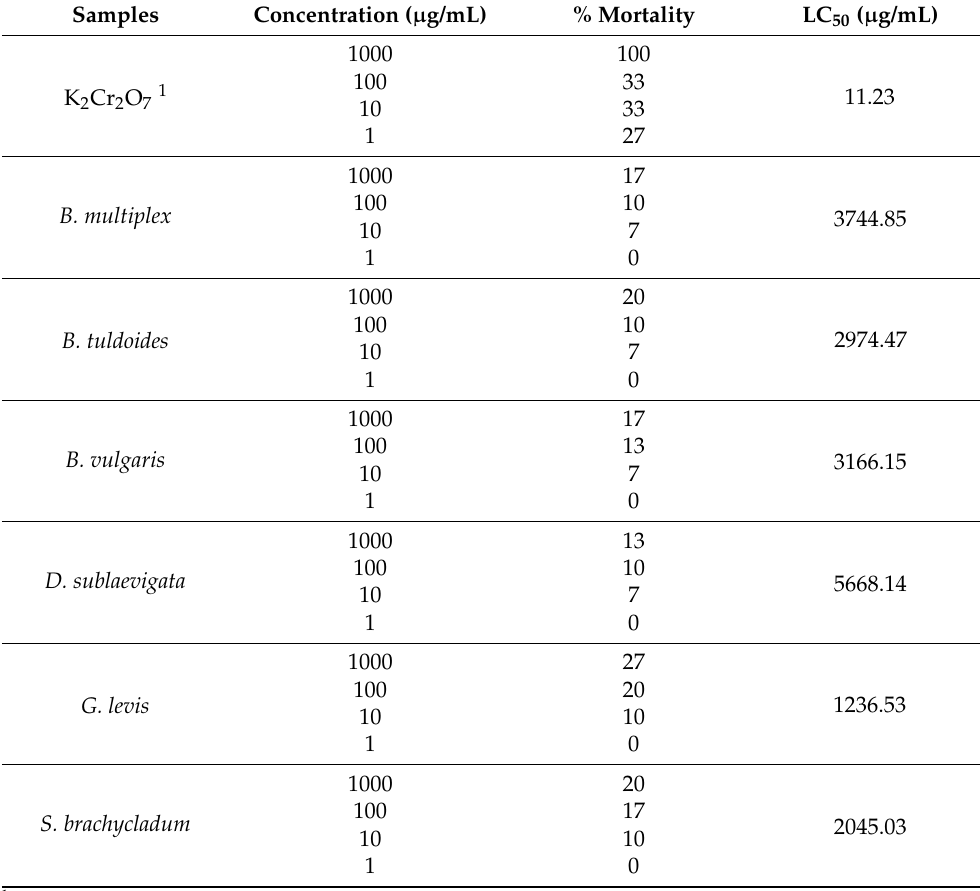
Table 4. The mortality percentage and lethality concentration of shrimp nauplii after treatment with the bamboo